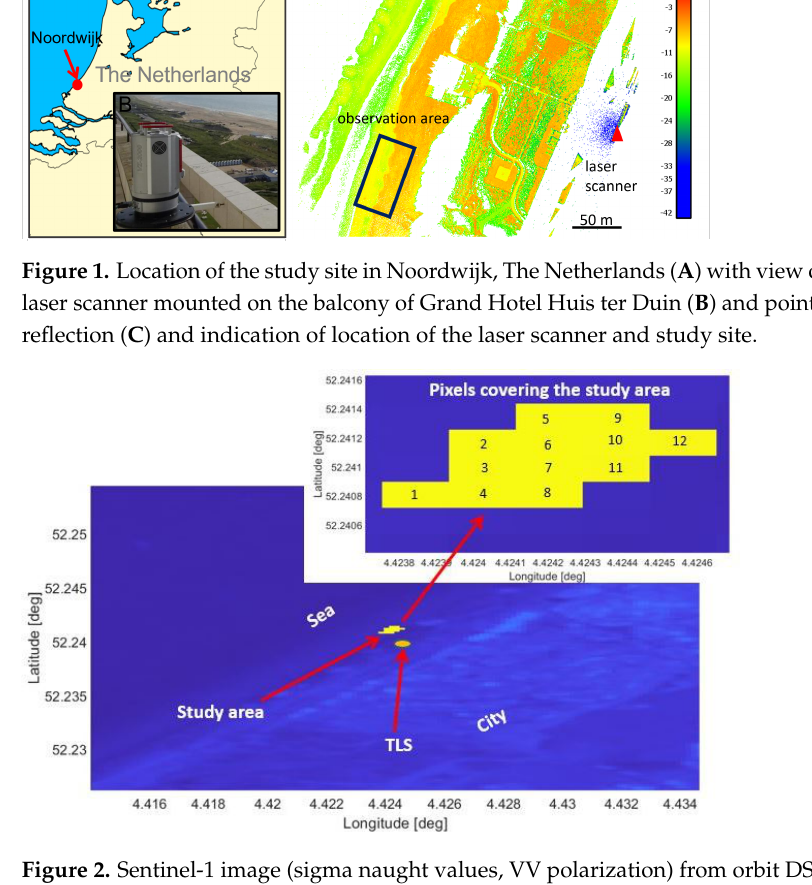
Figure 2. Sentinel-1 image (sigma naught values, VV polarization) from orbit DSC37: the study area is highlighted in yellow and its location is represented with respect to the city, the sea and the PLS position. Top right: the number of the SAR pixels covering the study